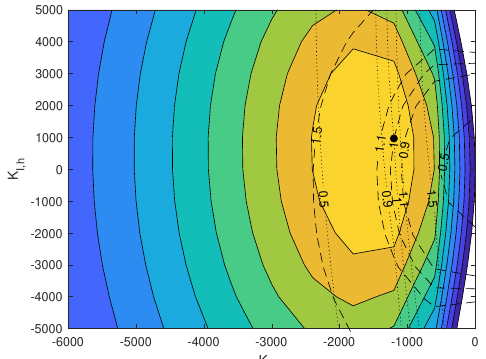
Fig. 8: Power contour of heave degree of freedom for Wave State 10. The hashed lines mark the PTO load contours and dotted lines are the fatigue damage contour for the heave